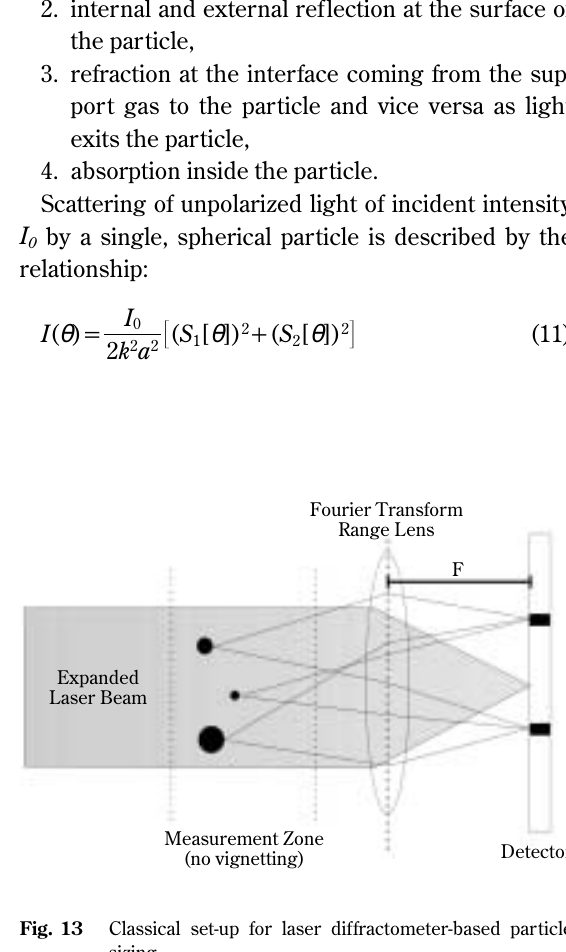
Classical set-up for laser diffractometer-based particle sizing